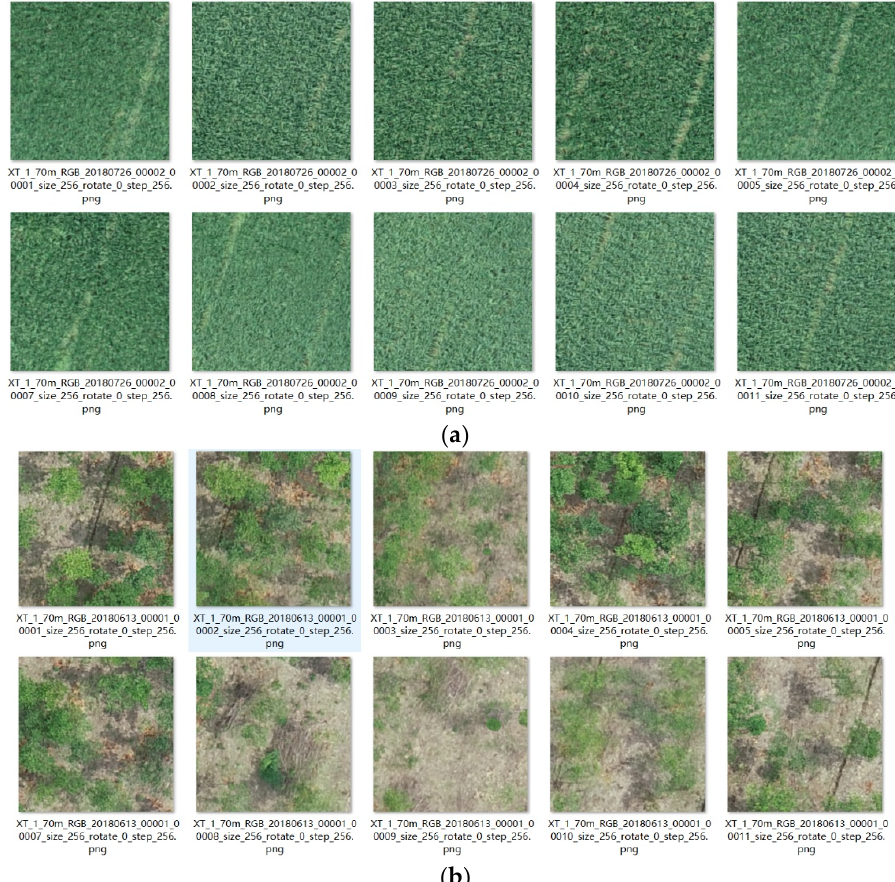
Figure 8. The results for the samples were generated from one field block. ( a ) The samples from middle-season rice in village 1 of Xiantao; ( b ) the samples from a non-middle-season rice field block in the same place.